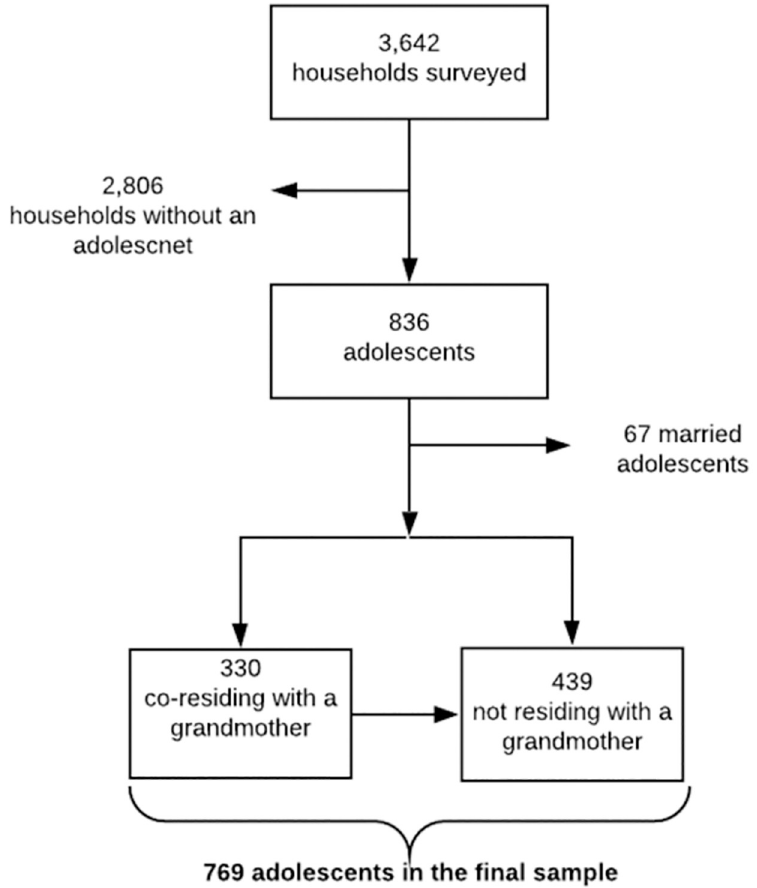
Fig 1. Flow chart to obtain study population from original